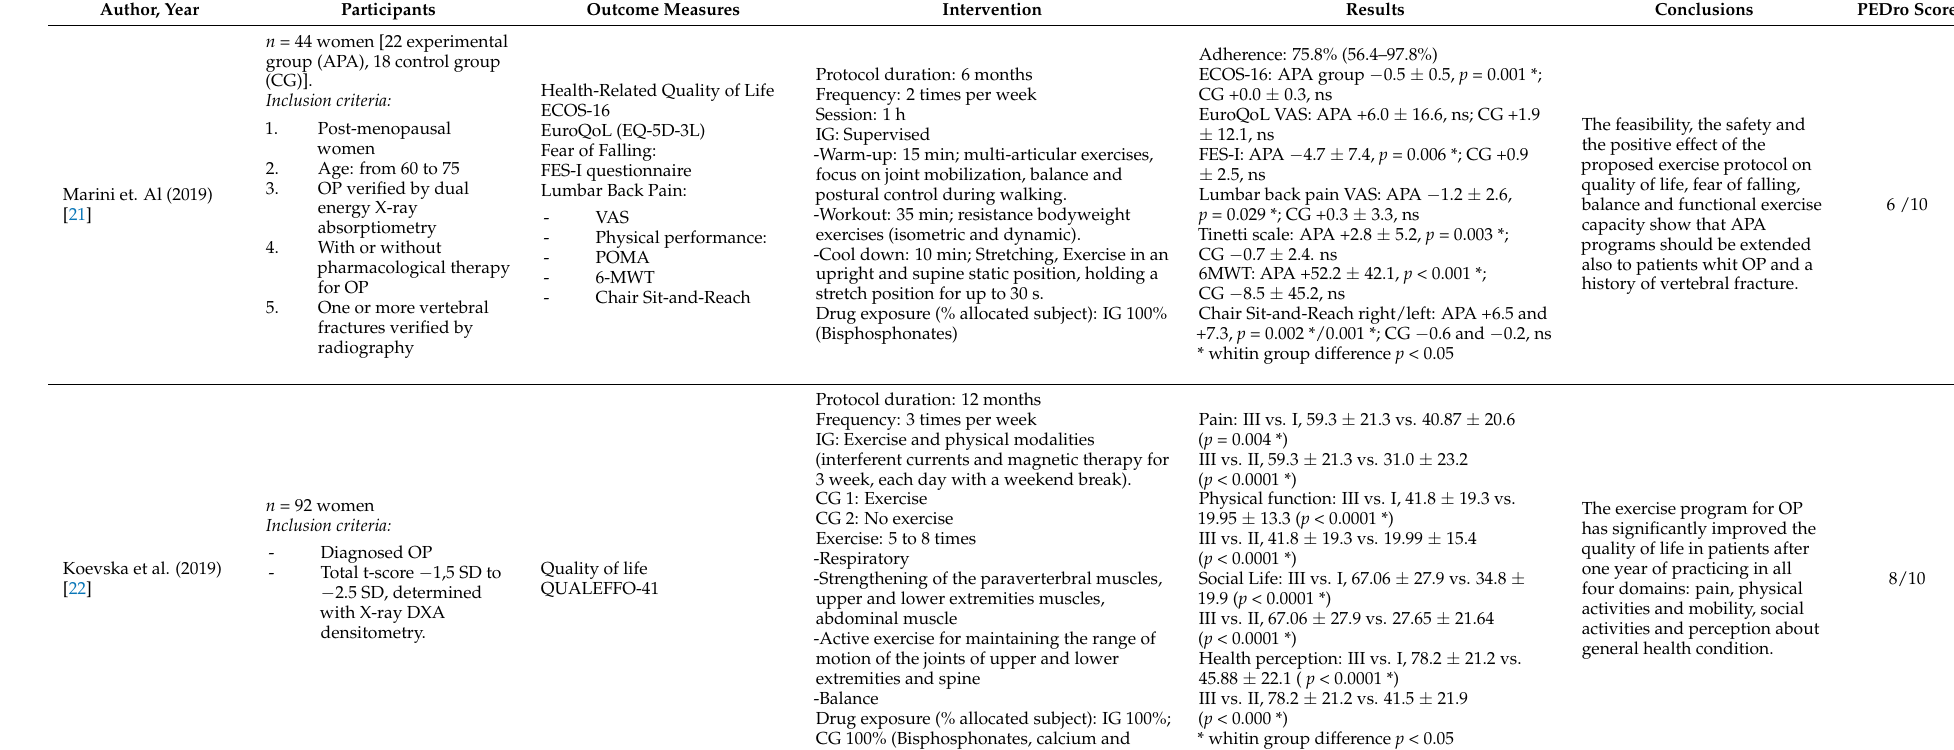
Table 1. Characteristics of included